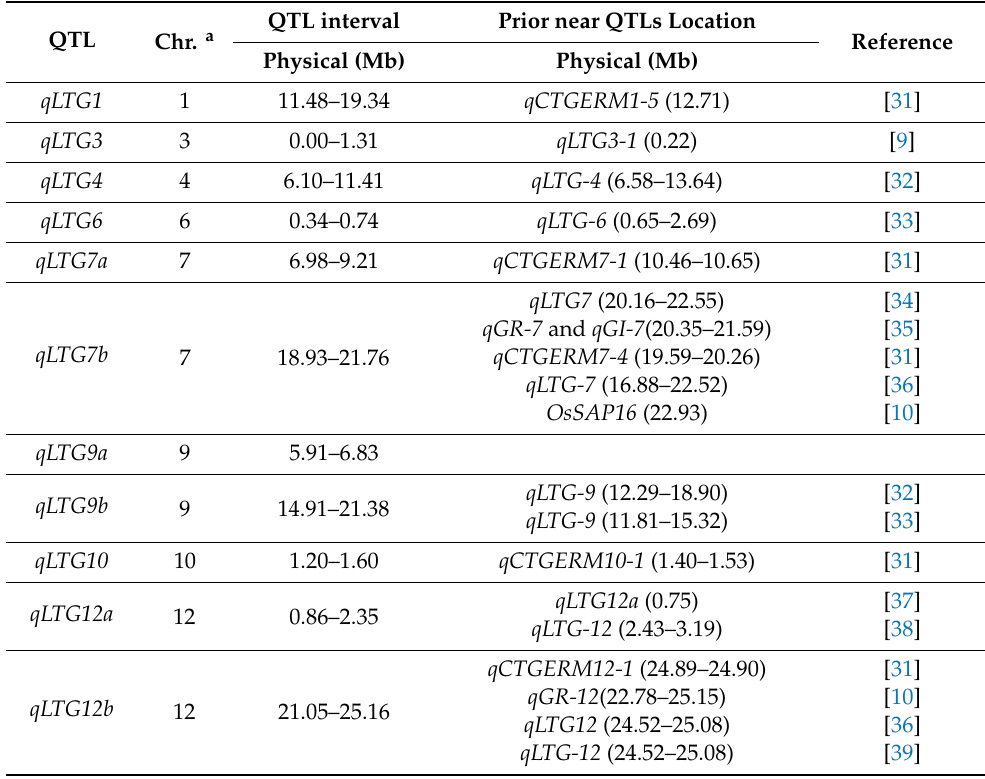
Table 5. Comparison of QTL positions on the rice